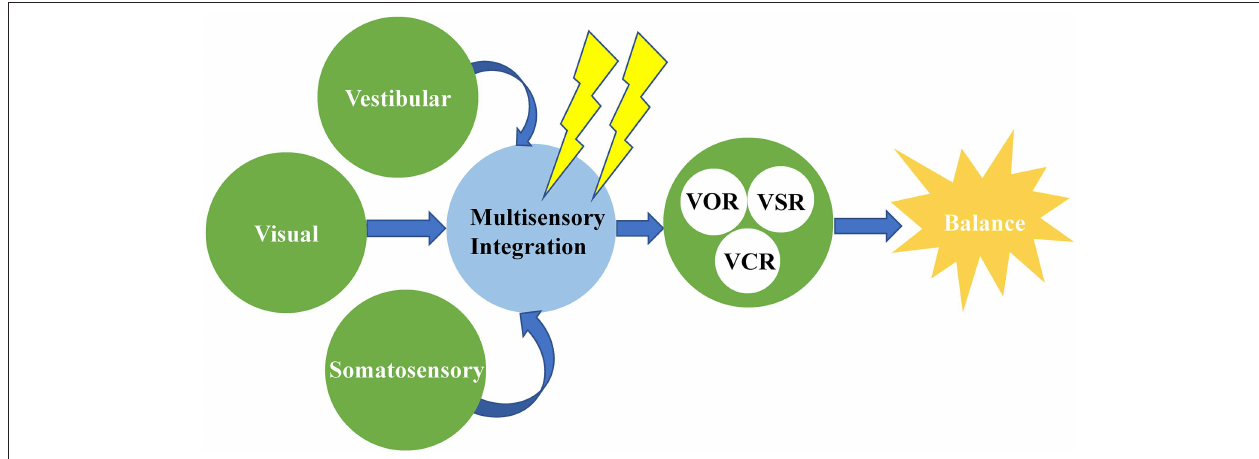
FIGURE 2 | Multisensory integration disorder leads to a decline in balance function in older adults. VOR, vestibulo-ocular reflex; VSR, vestibulospinal reflex; VCR, vestibulocolic